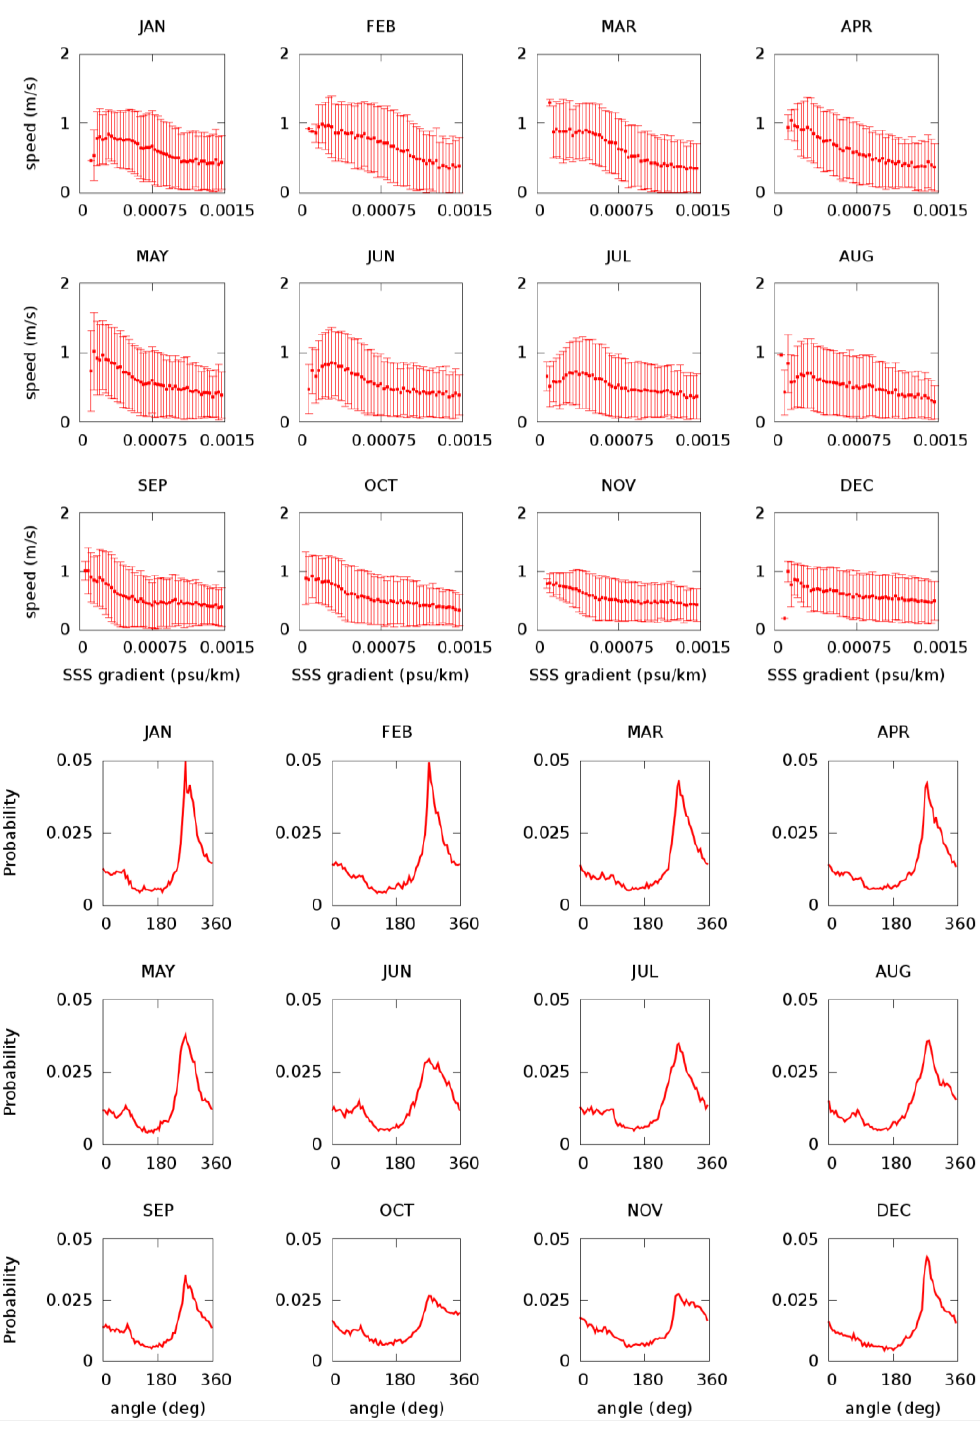
Figure 7. A s in Figure 5, but for the AL. Figure 7. As in Figure 5, but for the